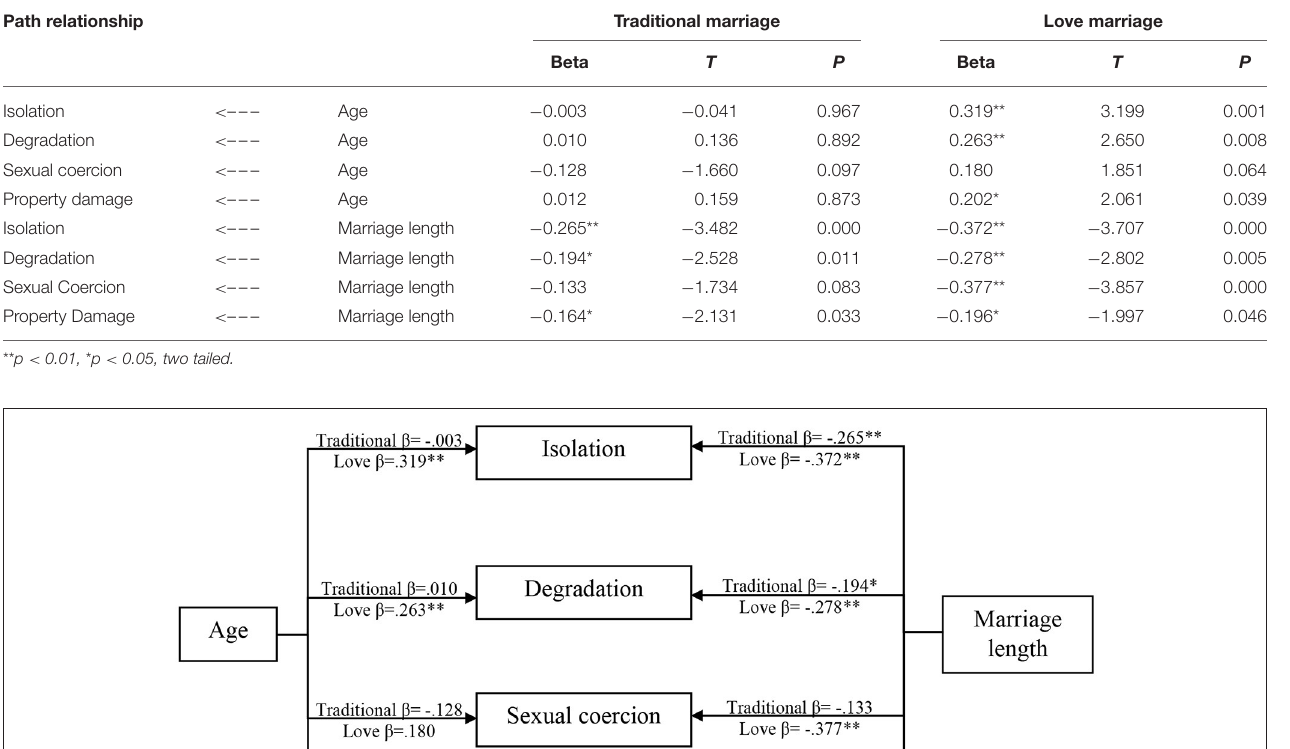
TABLE 9 | Multi-group modeling: interaction of marriage motivation on associations of age and marriage length with emotional abuse victimization.